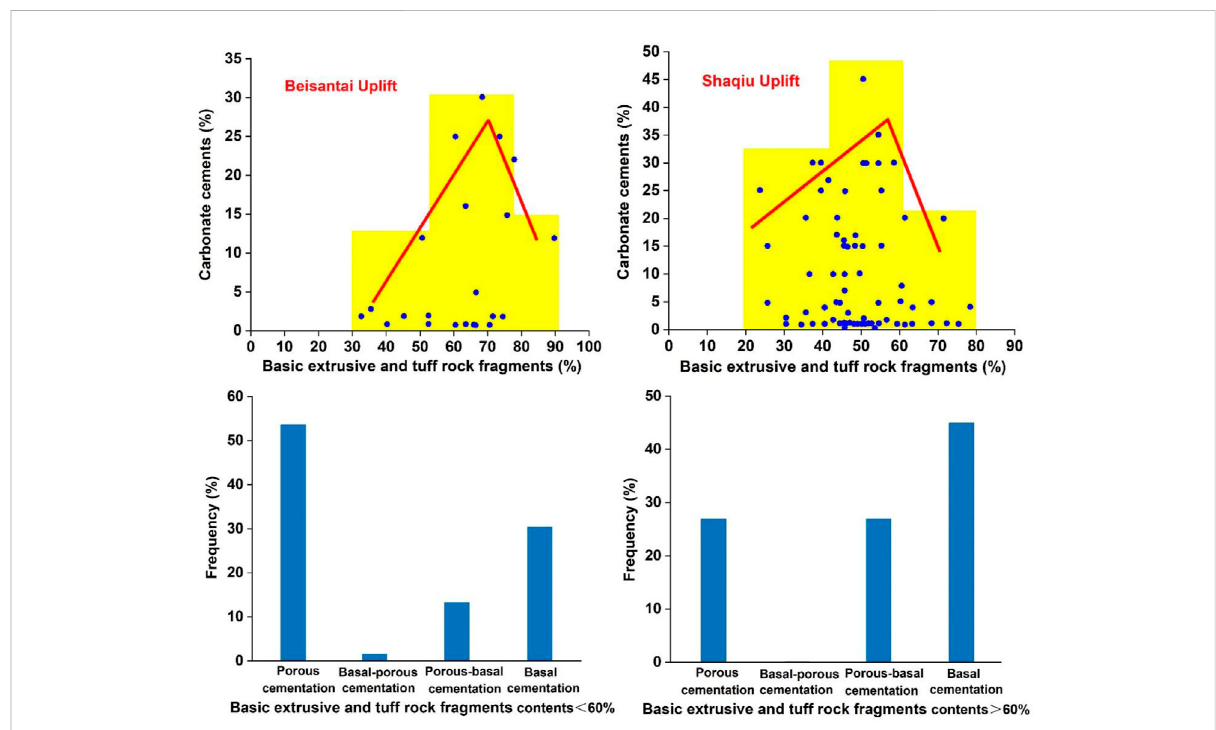
FIGURE 10 Relationships between the content of carbonate cement, the content of volcanic lithic fragments, and the types of cementation in Fukang